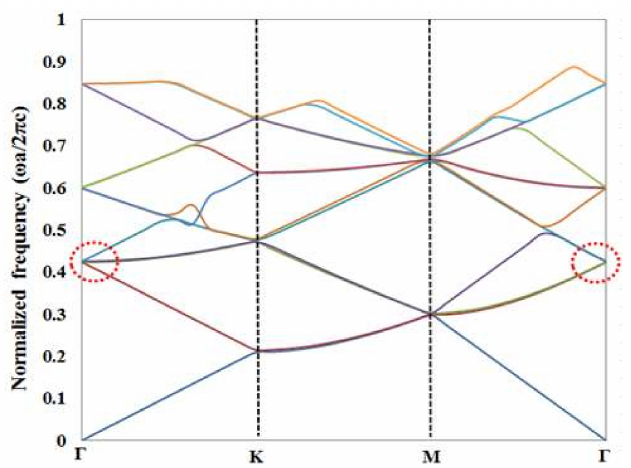
Figure 6. Photonic band structure of the proposed GaN-PCSELs with TiO 2 PhC of TE